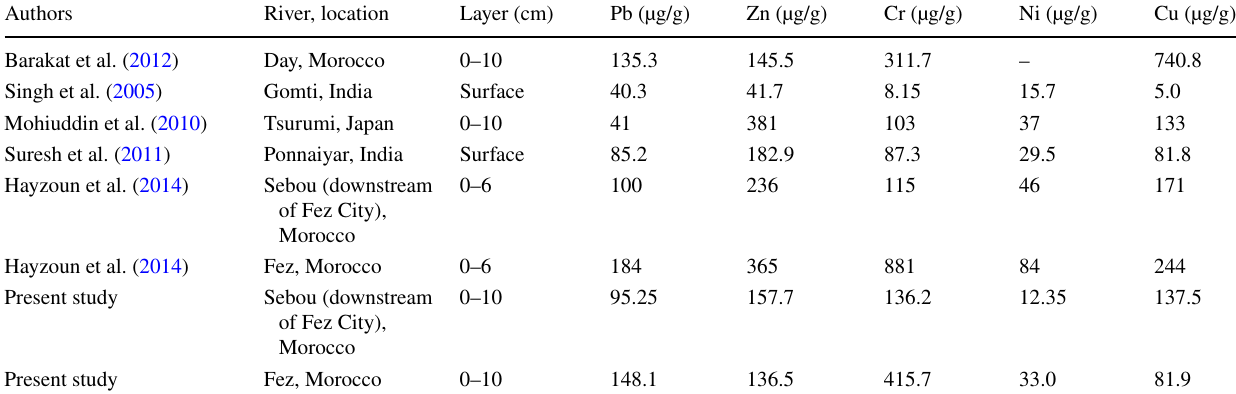
Table 2 Comparison of maximal trace metal contents in Sebou and Fez Rivers’ surface sediments in the present study and other studies of other Moroccan and international rivers